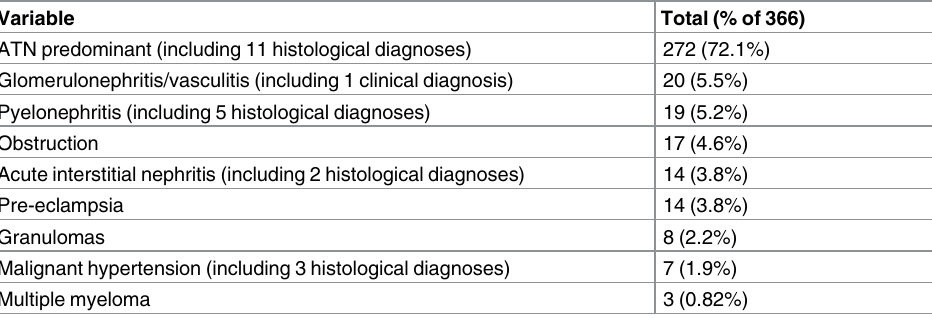
Table 2. Pathological diagnoses of AKI (including biopsy proven